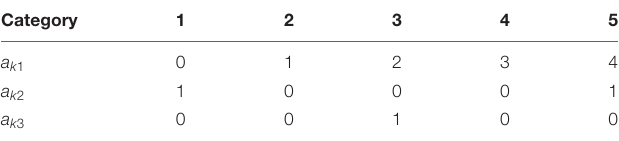
TABLE 1 | Scoring functions for the content factor, ERS and MRS.